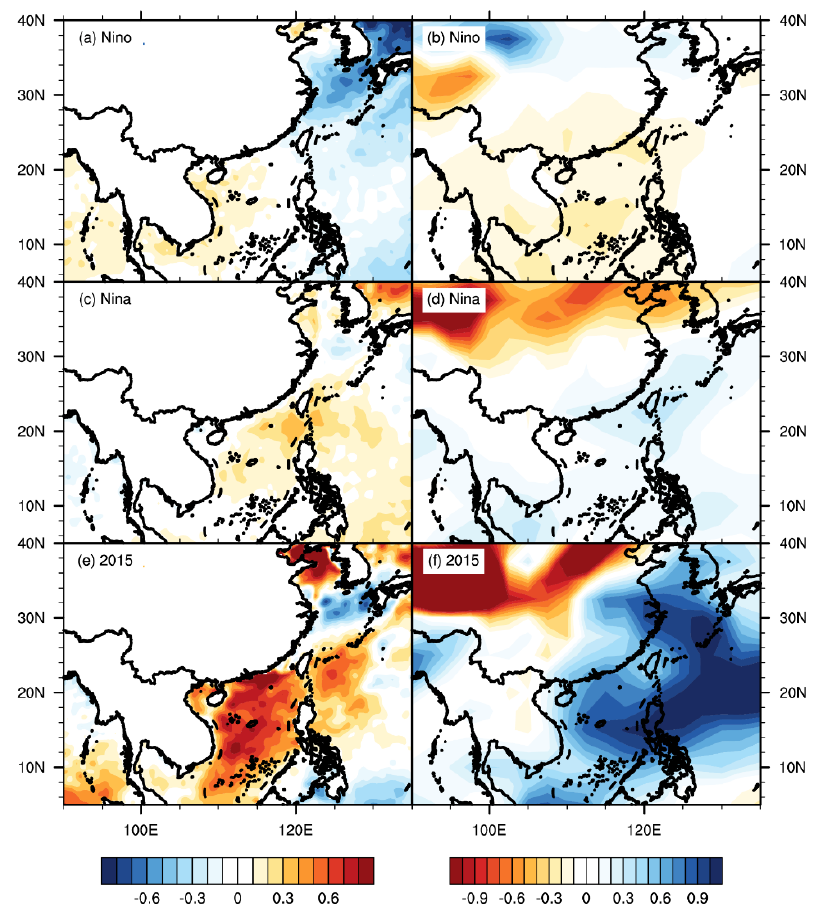
Figure 5. Average sea surface temperature (left; unit: K) and specific humidity at 700 hPa (right; unit: kg/kg) anomalies of JJA in ( a , b ) El Niño years, ( c , d ) La Nina years, and ( e , f ) 2015 from ERA5 reanalysis datasets.